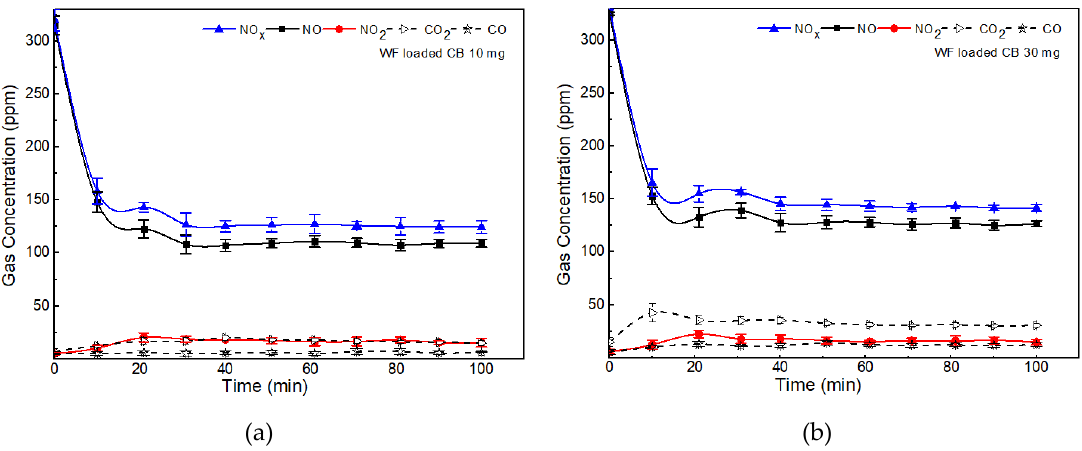
Figure 4. Effect of NO x removal in case: ( a ) wood fiber loaded CB = 10 mg; ( b ) wood fiber loaded CB = 30 mg; applied voltage 7.5 kV and SED 50 J/L (error bars indicate the standard deviation).